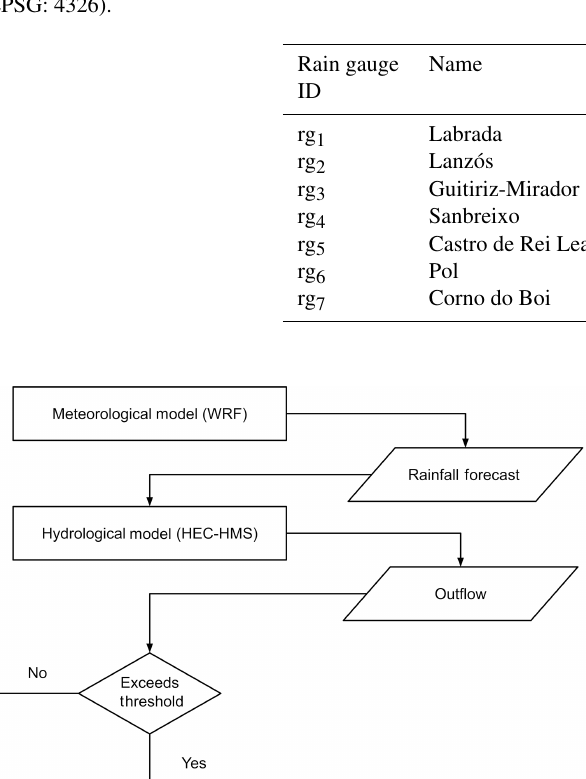
Table 1. Location and elevation of the rain gauges located in the area of study (the system of reference for latitude and longitude is the EPSG: 4326).